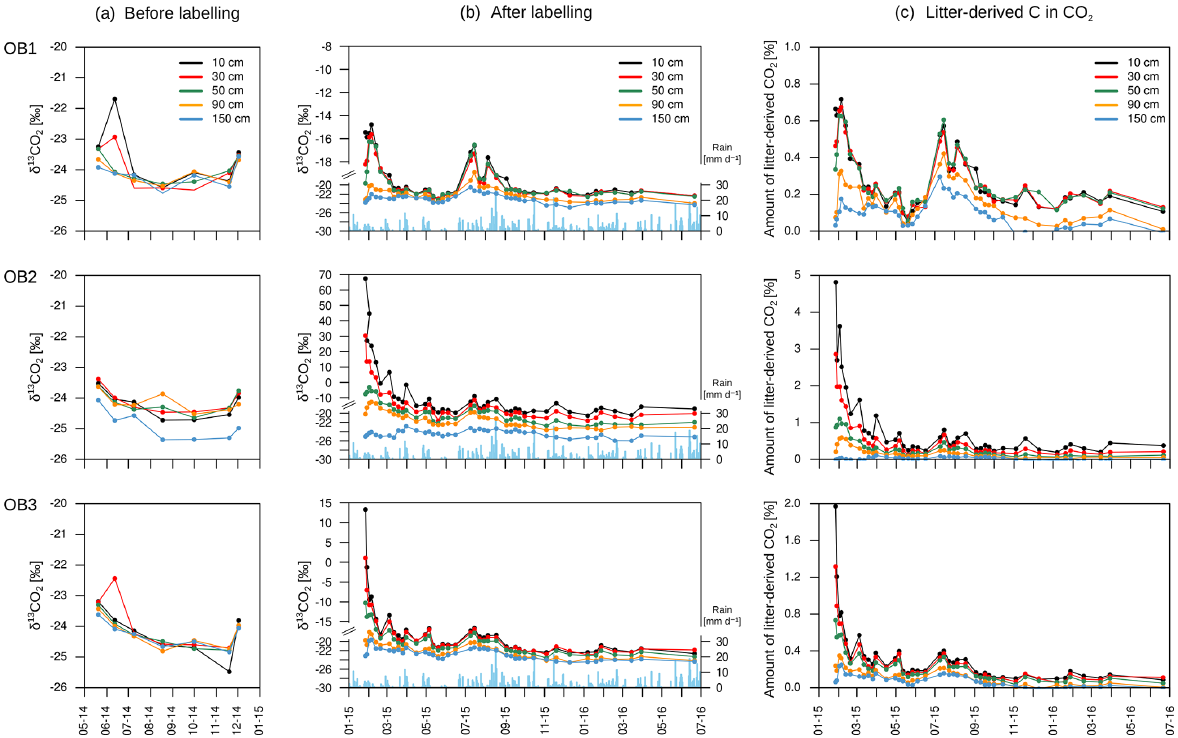
Figure 8. Isotopic signature of CO 2 at each depth and observatory (OB) before the addition of the labelled litter (a) and after the labelled litter addition (b) , with daily precipitation data (blue bars). The relative amount of litter-derived CO 2 on total CO 2 at each depth and observatory (c) . Please note the different y -axis ranges for (b) and (c) .